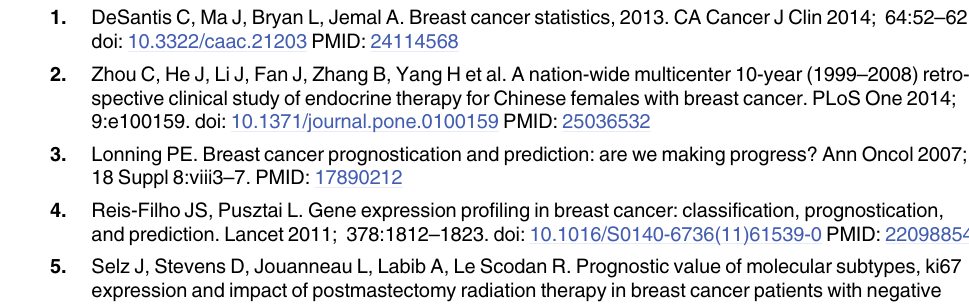
S1 Fig. Parts of original clinicopathological data of